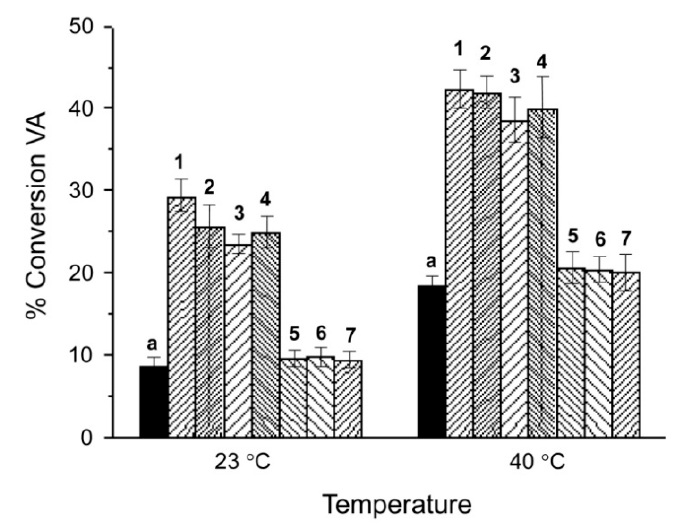
Figure 5. Conversion rates of veratrylalcohol (VA) to veratrylaldehyde (VAH) at 23 and 40 °C after 2 h without catalyst (a) and with catalysts ( 1–7 ); pH = 8.25.